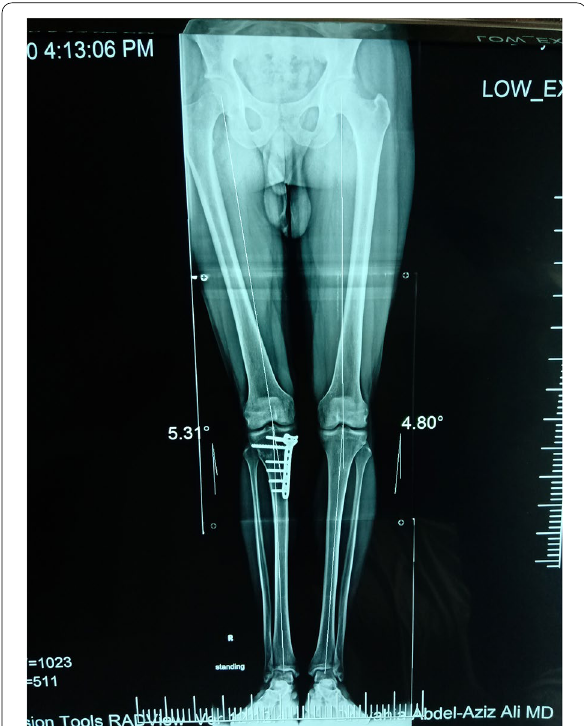
Fig. 9 Postoperative long standing film